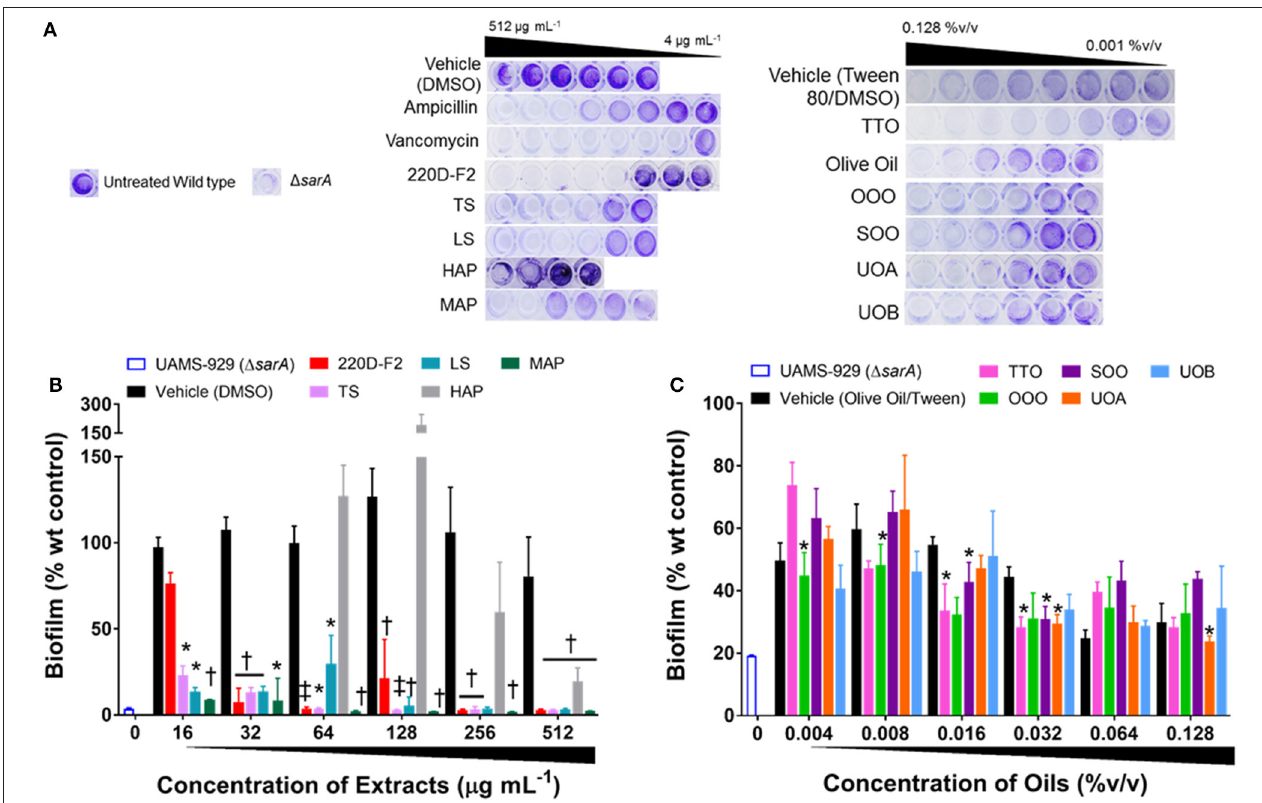
FIGURE 7 | Impact of H. perforatum extracts on S. aureus biofilm formation, as detected by static microtiter plate crystal violet assay. USA 200 isolate UAMS-1 and its isogenic sarA mutant (UAMS-929) were used in the biofilm assay. (A) Images of crystal violet stained biofilm in 96-well plates. The optical density (OD 595 nm ) of the biofilm eluent is reported as percent of the wild type control (UAMS-1) for the (B) organic and (C) oil extracts. Significance is denoted as * P < 0.05, † P < 0.01, and ‡ P < 0.001.